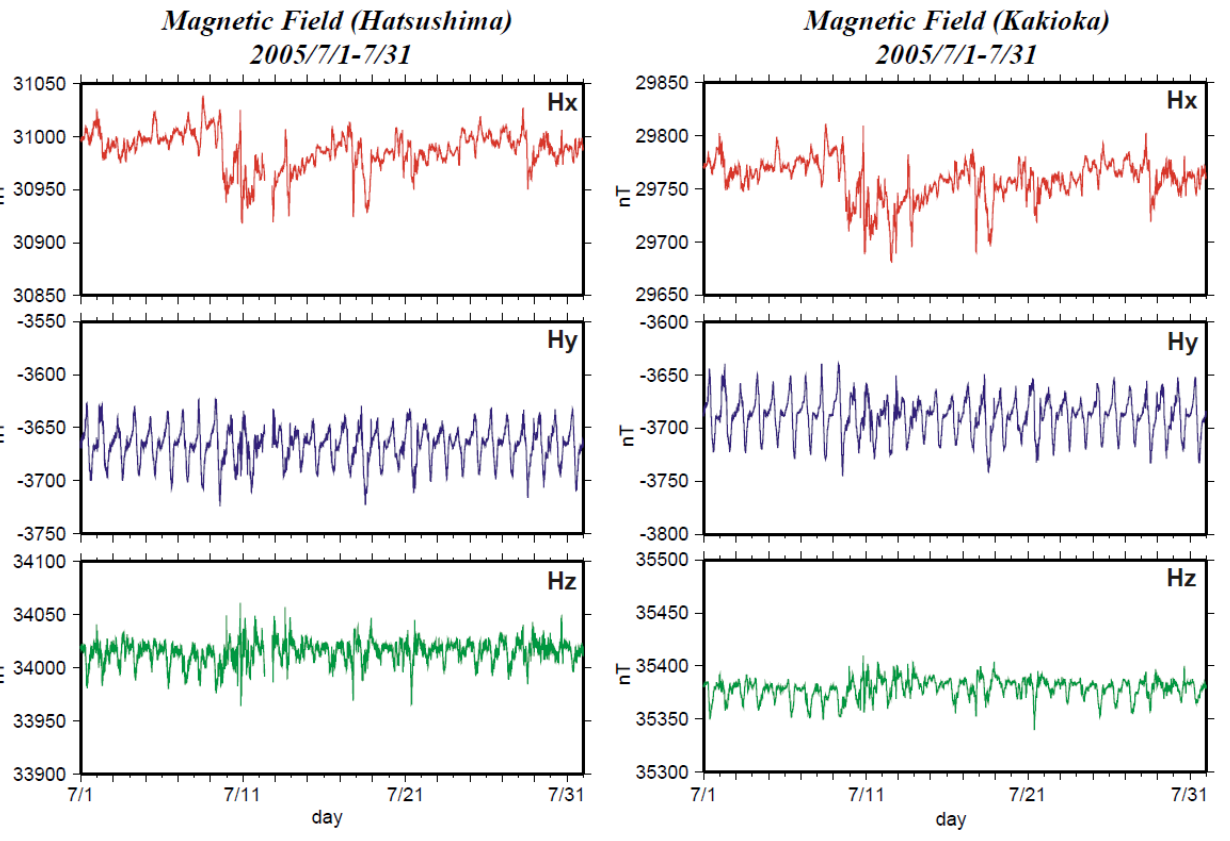
Figure 4. Comparison of the magnetic component’s monthly variation deduced by Hatsushima Observatory and Kakioka Observatory in Ibaragi